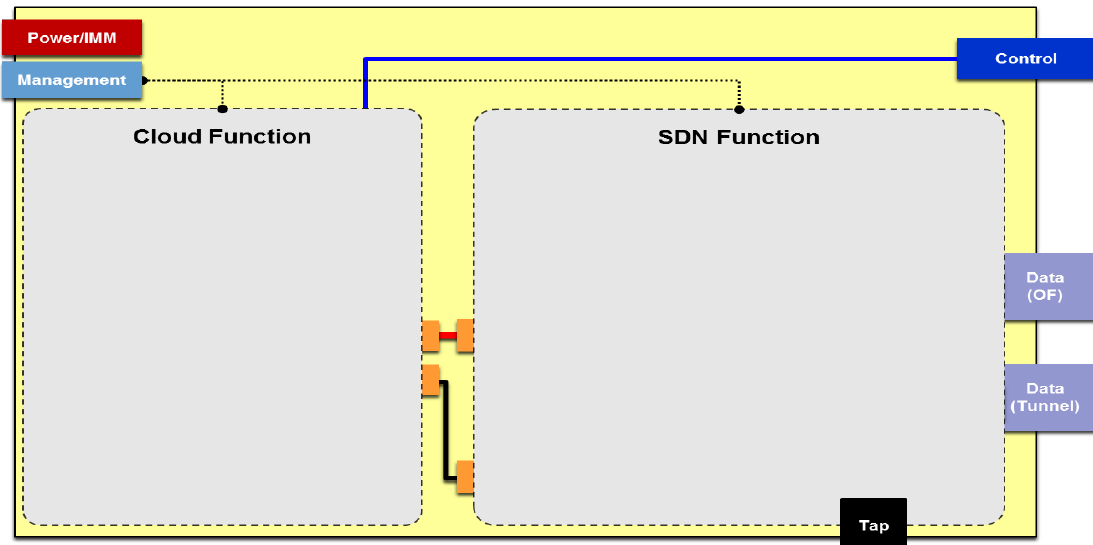
Figure 6. Hyper-converged SmartX Box Design for SDN and Cloud Integration.